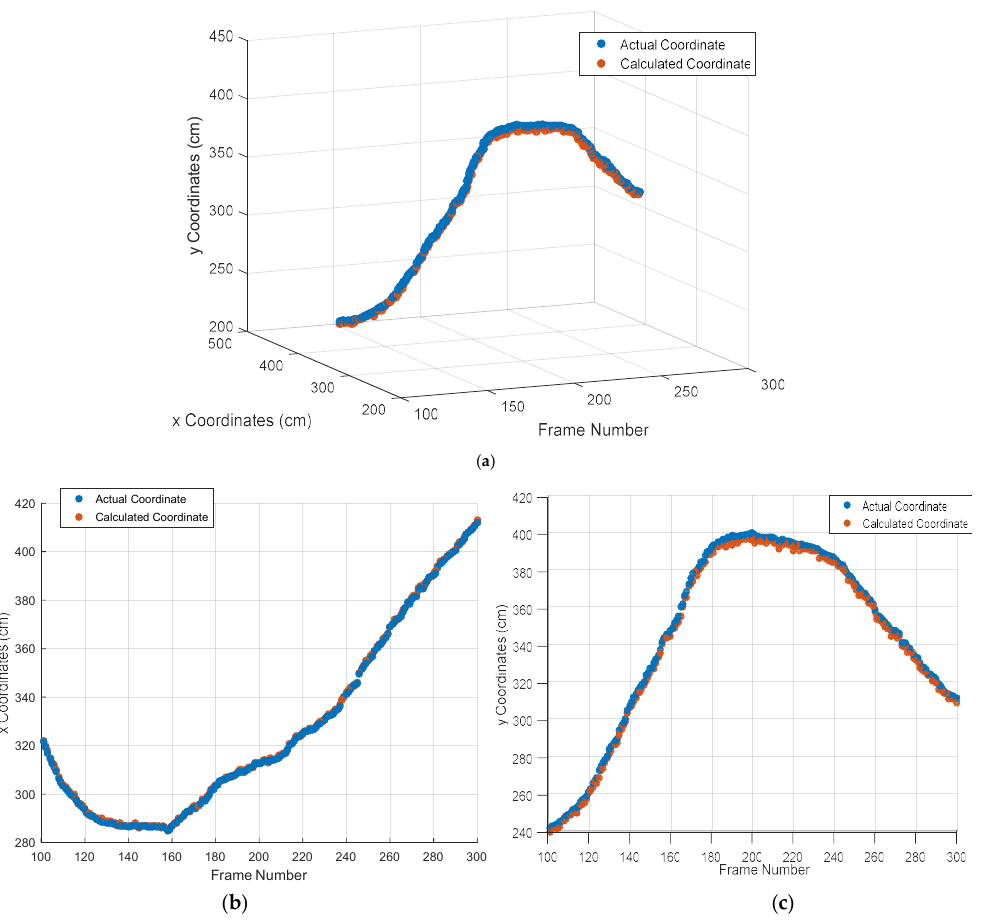
Figure 8. The calculated coordinate value and the actual coordinate value of the target signal source LED: ( a ) tracking result of the target signal source LED, ( b ) Tracking result of the 𝑥 coordinate, and ( c ) tracking result of the 𝑦 coordinate.